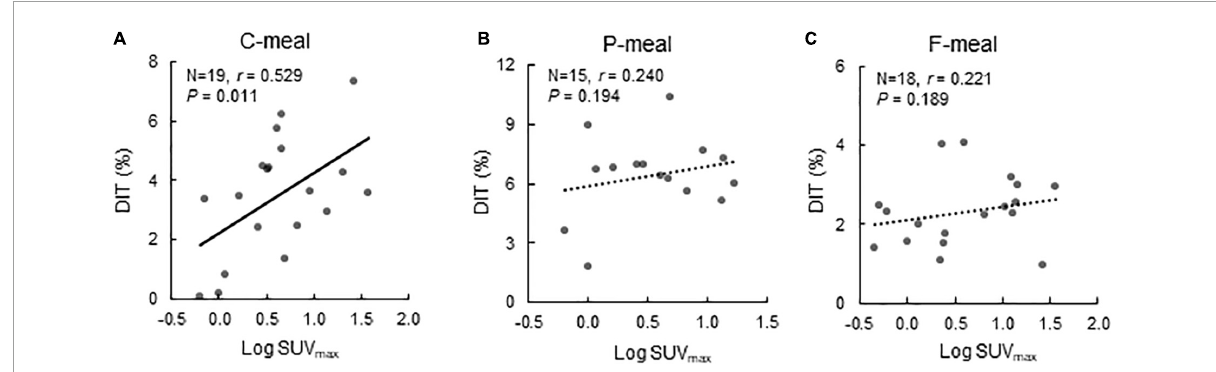
FIGURE4 Correlation between BAT activity and diet-induced thermogenesis. Correlation between BAT activity expressed as Log SUV max and diet-induced thermogenesis (DIT) after ingestion of a carbohydrate-rich C-meal (A) , a protein-rich P-meal (B) , and a fat-rich F-meal (C) . r: Correlation